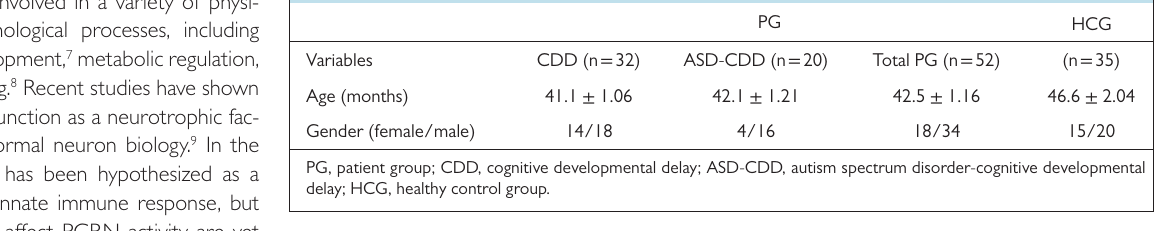
Table 1. Demographic Characteristics of the Control and Patients Groups